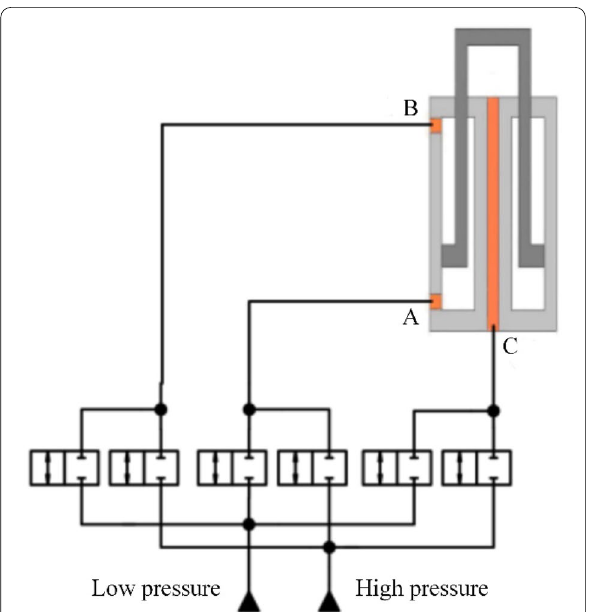
Figure 28 Multi-chamber cylinder developed by Linjama et